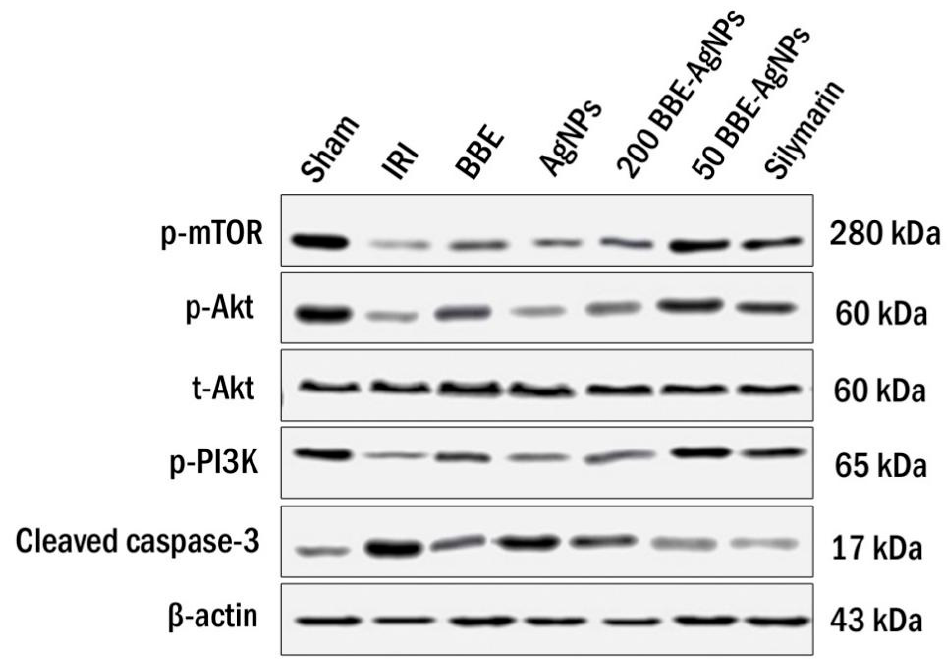
Figure 7. Representative western blot analysis. Bands of the measured proteins in liver of the studied groups. Bands represent Sham, IRI, BBE , AgNPs, 200 BEE ‐ AgNPs, 50 BBE ‐ AgNPs and Si ‐ lymarin.